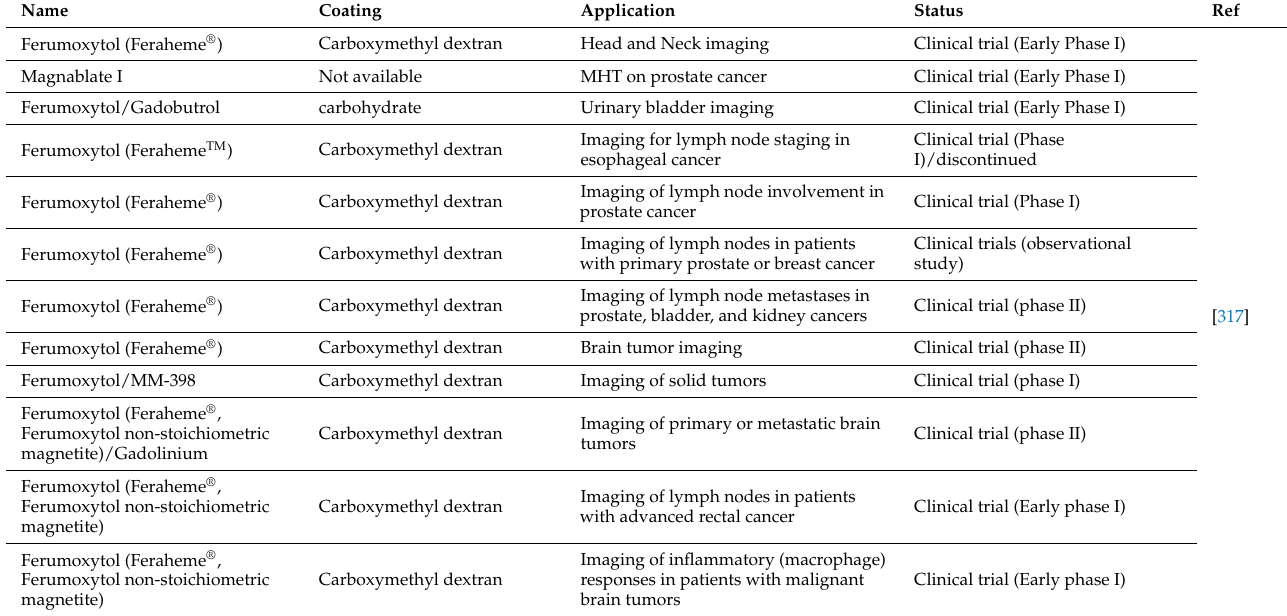
Table 12. Magnetic iron oxide nanoparticles approved or in clinical